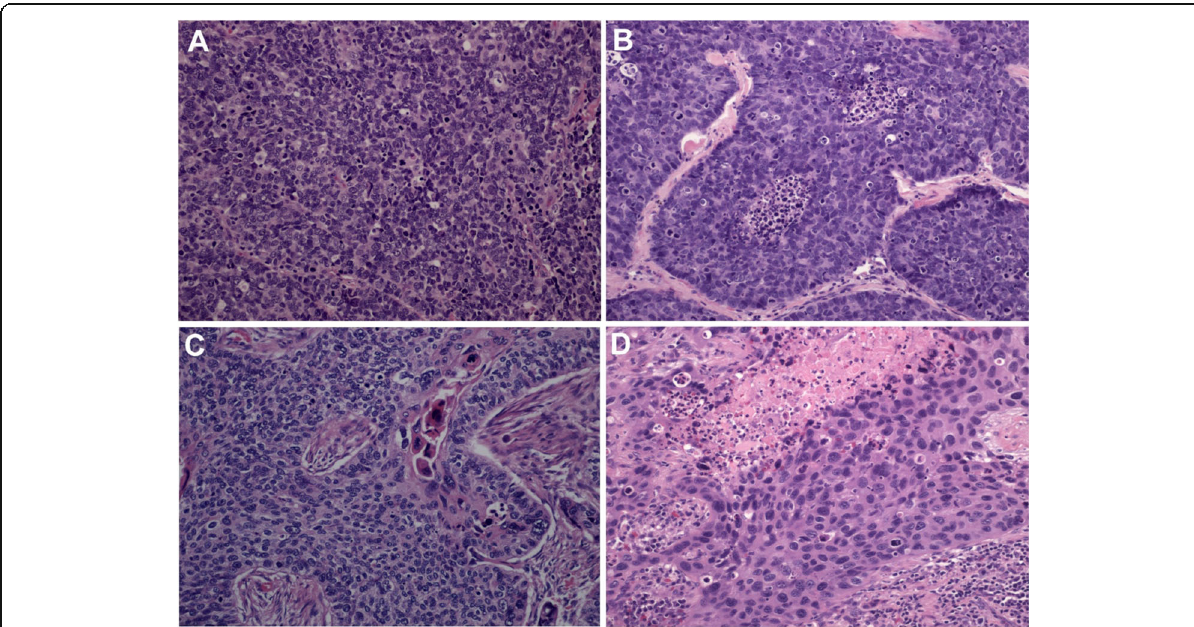
Fig. 1 The photomicrograph shows morphological features of A small cell lung carcinoma, B pure-basaloid squamous cell carcinoma, C basaloid squamous cell carcinoma (focal <50% squamous cell differentiation) and D poorly differentiated squamous cell